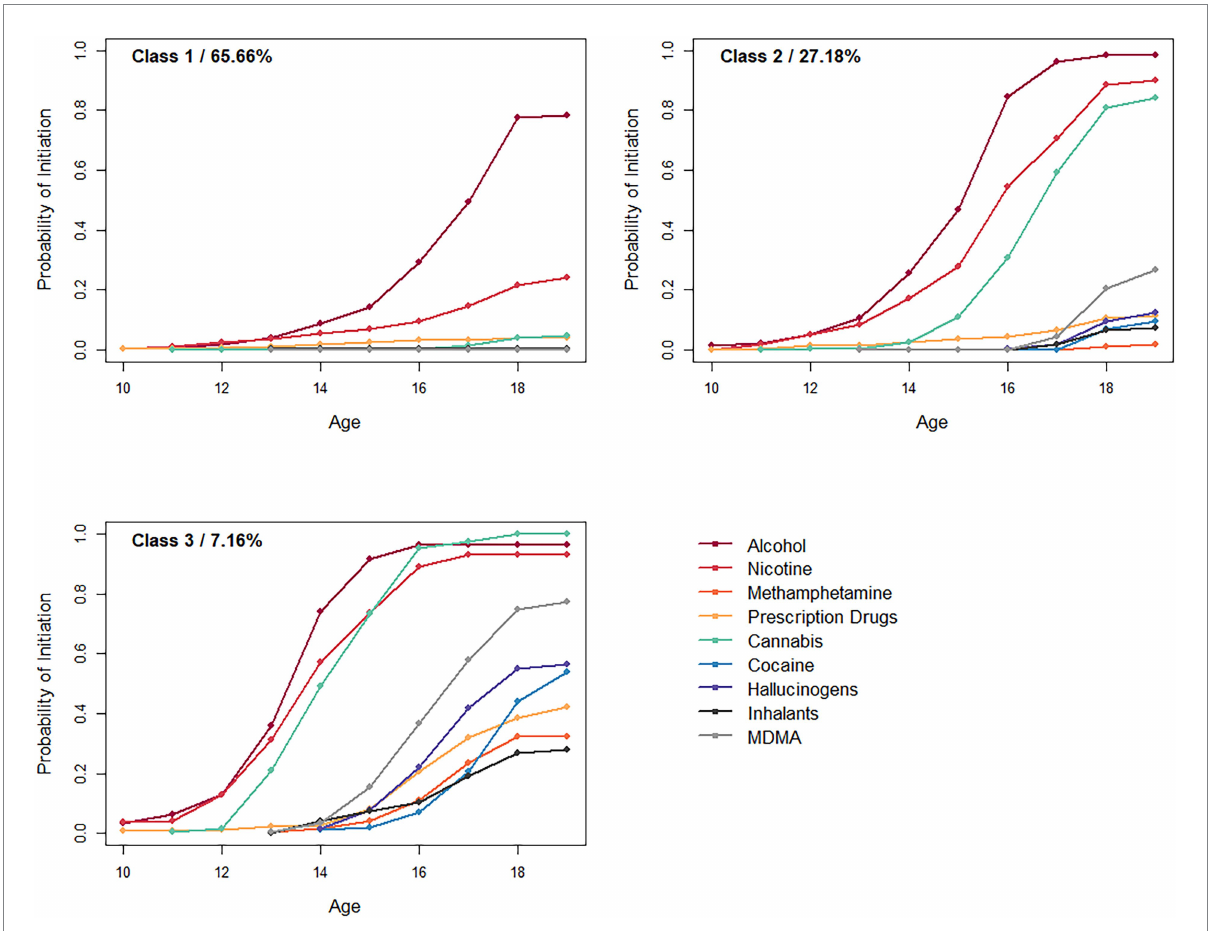
FIGURE 1 Probability of initiating use of each substance for each